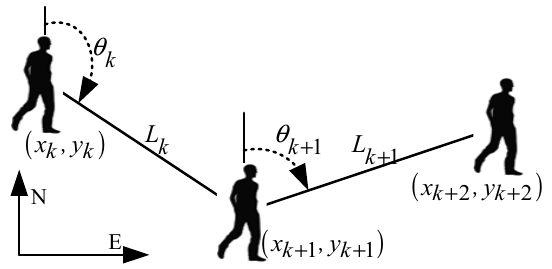
Figure 12. Schematic of PDR.